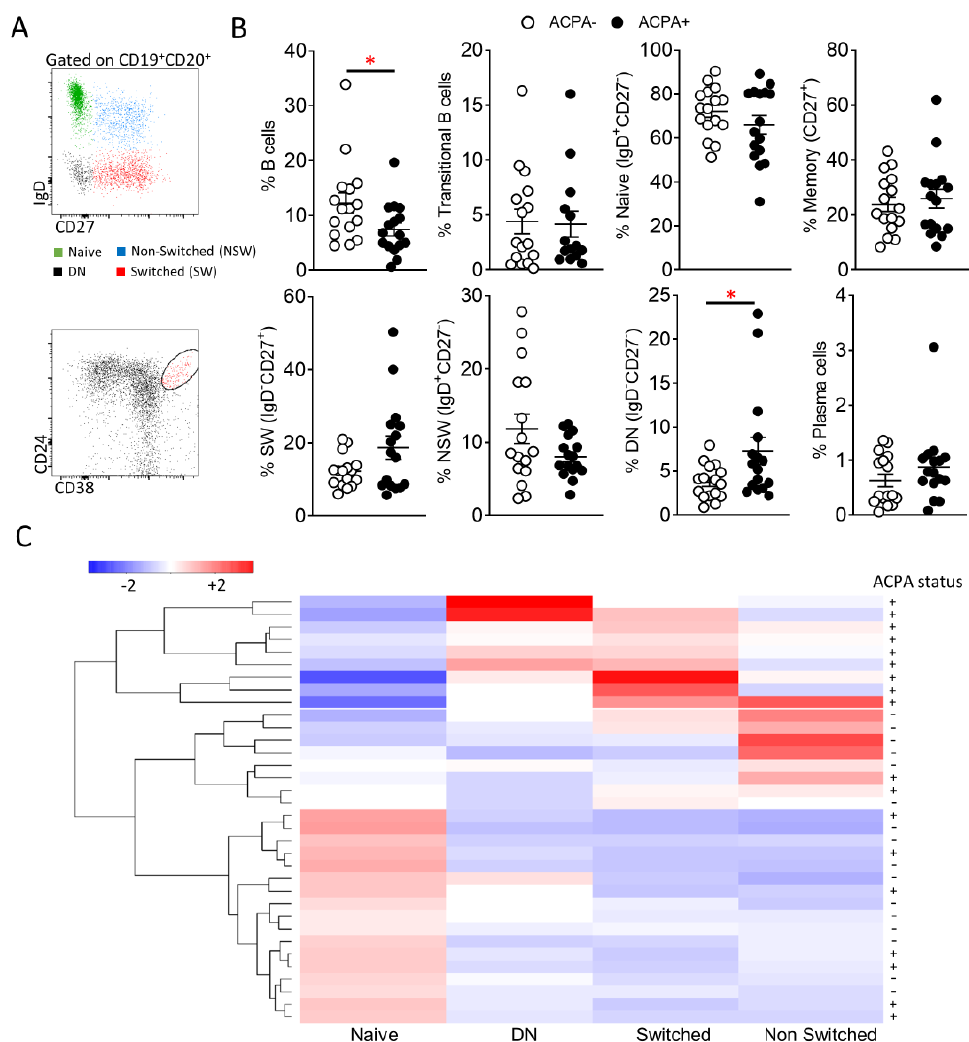
Figure 1. B cell subpopulation profile of ACPA− and ACPA+ RA patients. ( A ) Representative flow cytometric analysis for the identification of Naïve (IgD + CD27 − ), Non-switched memory (IgD + CD27 + ), Switched memory (IgD − CD27 + ), Double negative memory (IgD − CD27 − ) and transitional (CD24 ++ CD38 ++ ) peripheral blood B cells. ( B ) Frequency of the indicated peripheral blood B cell subpopulations of ACPA ( n = 16) and ACPA+ ( n = 17) RA patients. ( C ) Hierarchical clustering of ACPA− and ACPA+ RA patients based on scaled frequency of 4 major B cell subpopulations. Data are presented as mean ± SEM, symbols represent individual samples. Statistical analysis was performed by using two-tailed Mann-Whitney test, p < 0.05 * were considered significant.